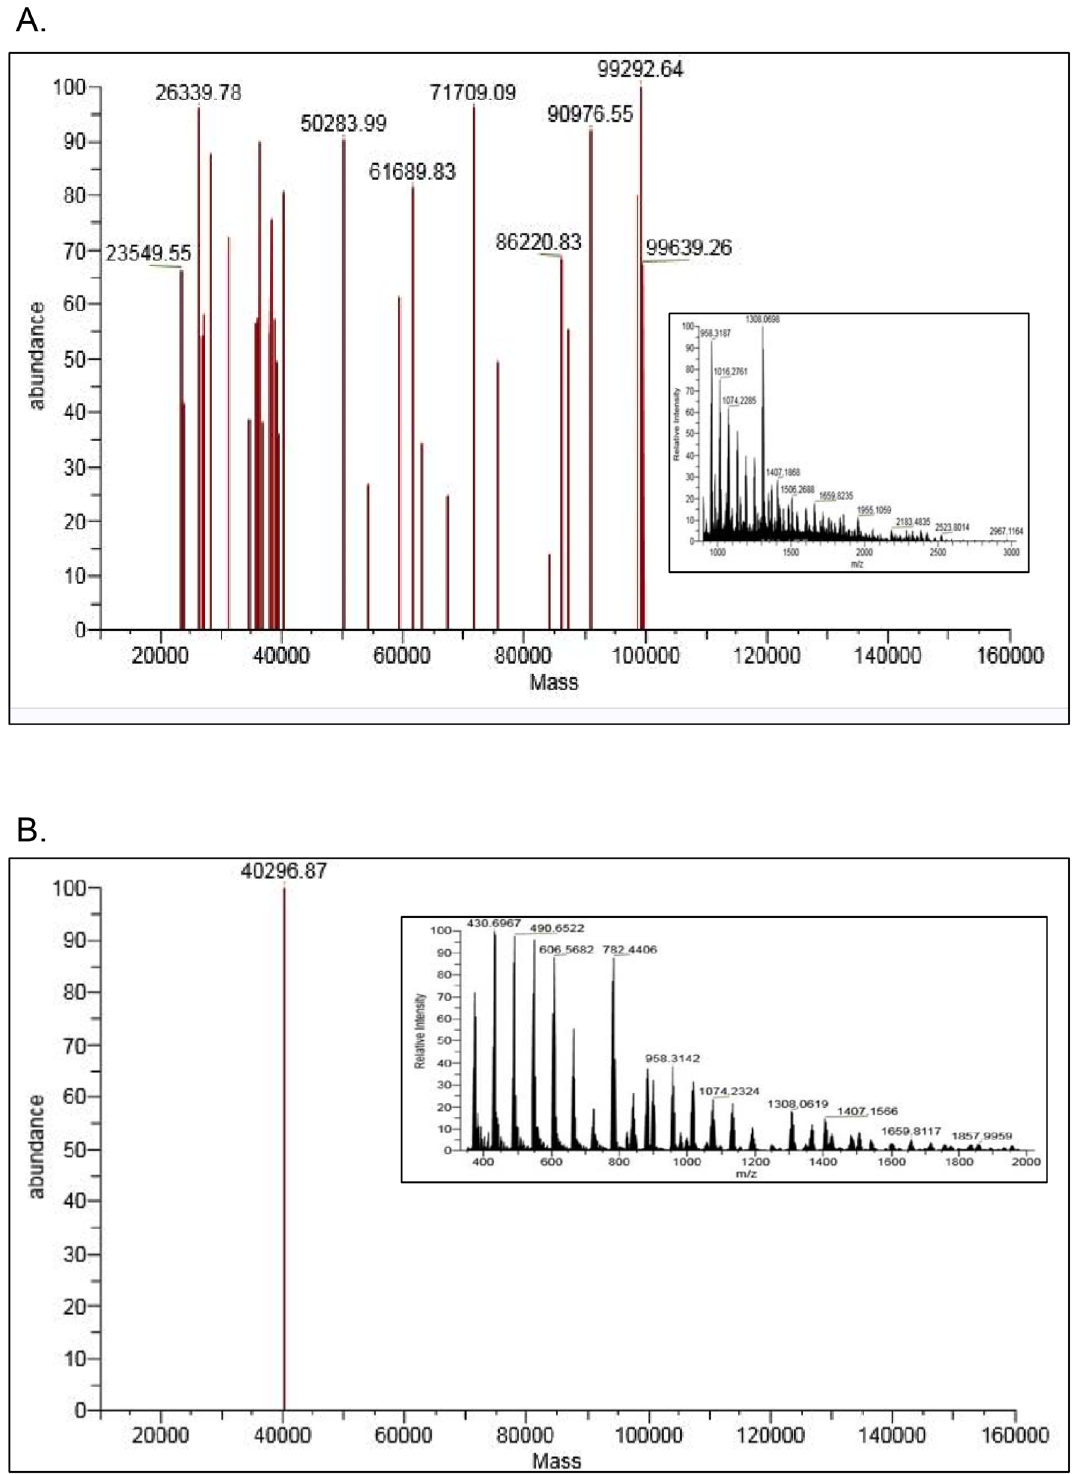
Figure 4. Intact mass determination of AAR using LC-ESI Mass spectroscopy. ( A ) Deconvoluted mass spectrum of AAR; inset shows full ESI–MS Scan profile of AAR. ( B ) Intact mass determination of de-lipidated AAR using LC-ESI Mass spectroscopy-deconvoluted Mass spectrum of MAYI-ODS treated AAR; inset shows full ESI–MS scan of MAYI-ODS treated